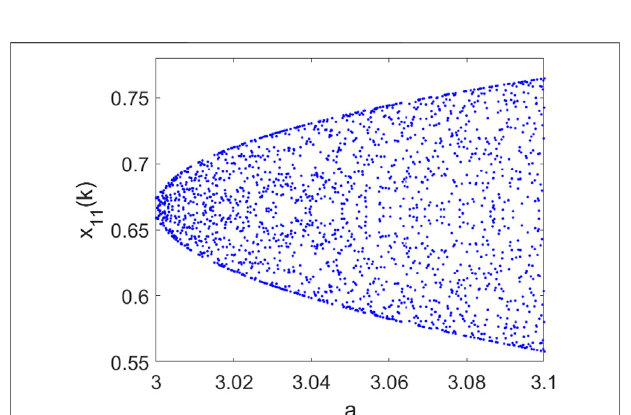
FIGURE 7 | Probability of having off-diagonal maps converging to zero in the multidimensional logistic map with N = 2: (A) Period-2 window ( r = 2); (B) period-4 window ( r = 4). The continuous lines refer to the exact formula p off (cid:2) r , while the markers indicate the probability calculated over 100,000 different initial conditions. r N